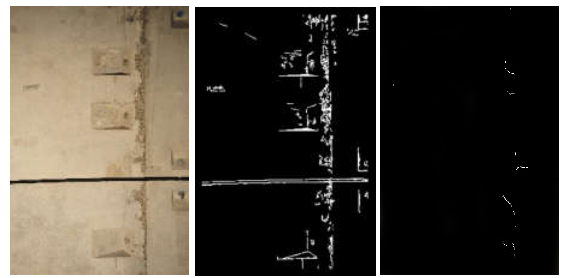
Figure 6. Left : original image; m iddle : possible defect areas presented for validation; right : CNN output after training.